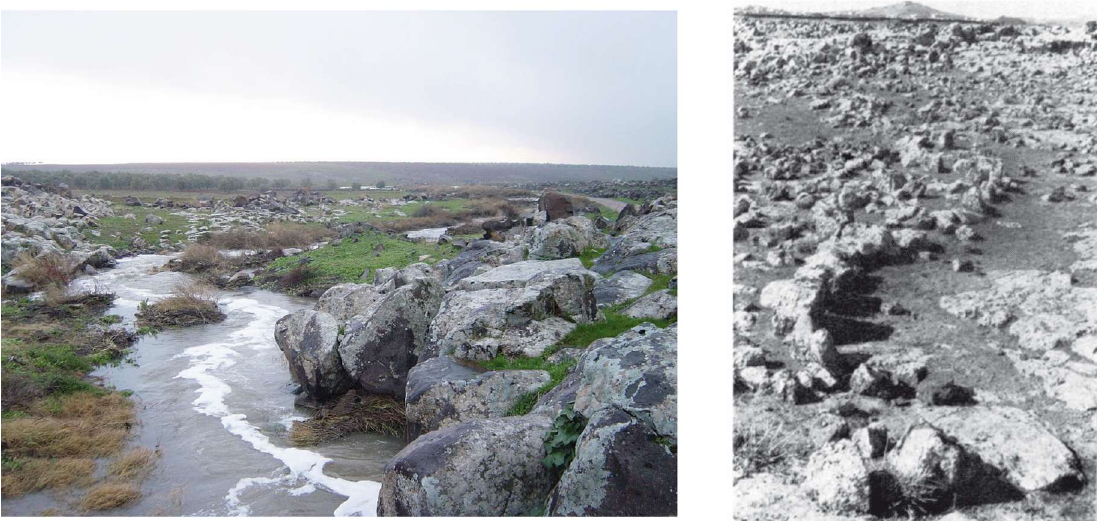
Figure 5. Examples of canals or conducts and wadis in Hauran. Canals are ca. 1.5 m wide and 0.5 m deep. Left : A wadi west of Soada/Suweida filled with water after rainfall. ©Hayan Hmidan, cc-by-2.0 [79]. Right : Canal of Kharsa/Salakhed (east of Bostra). [59] (Figure 16).